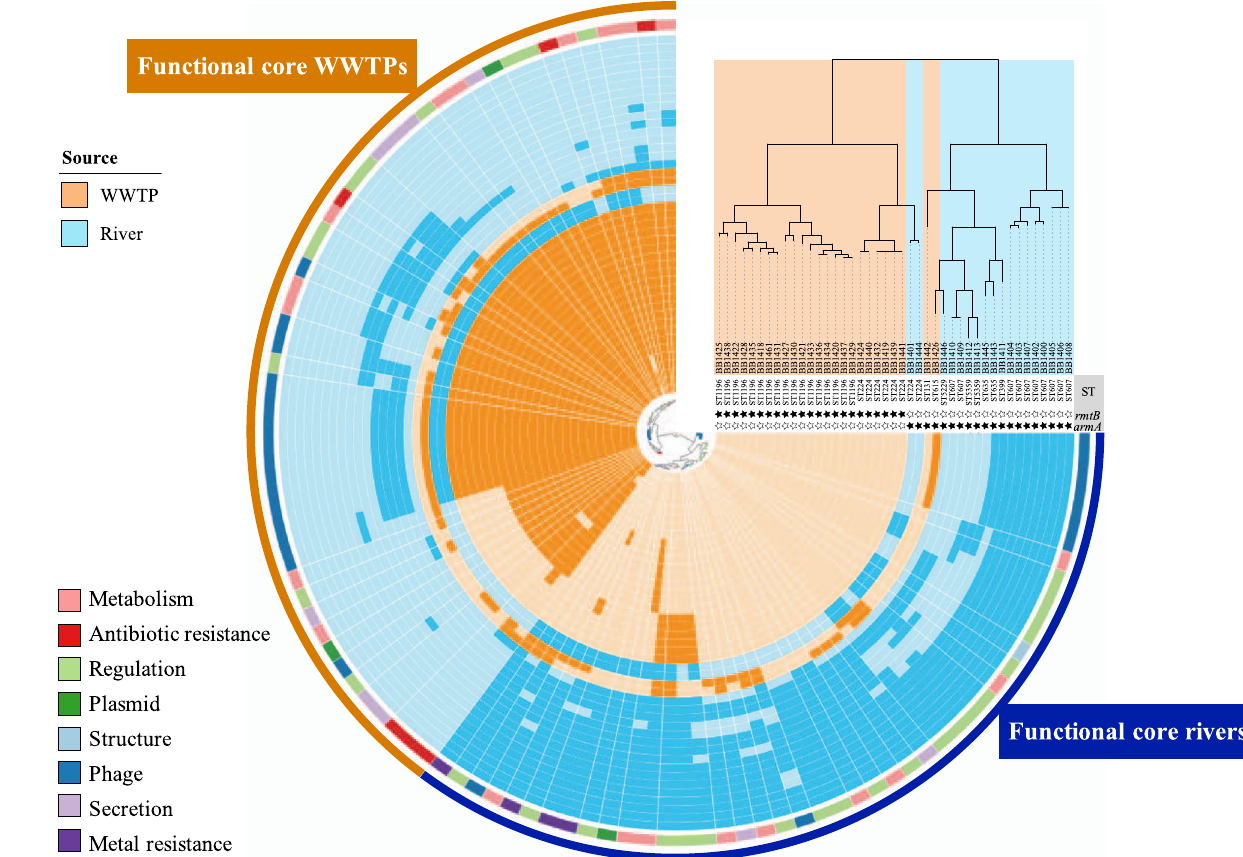
Fig. 4 Functional core-genome E. coli analysis. The origin of the isolates is indicated by colors in the tree and the circular diagram. E. coli ST is indicated in the tips, as well as the presence (black star) and the absence (white star) of 16S-RMTas genes. Functional core-genome tree distribution is based on all predicted functions. A circular diagram shows the presence (dark color) and absence (light color) of functions that are speci fi cally related to one of the environments. Inner ring colors indicate the different functions according to the classi fi cation shown in the legend. Outer ring colors indicate the functions related to the functional core-genome of wastewater and river